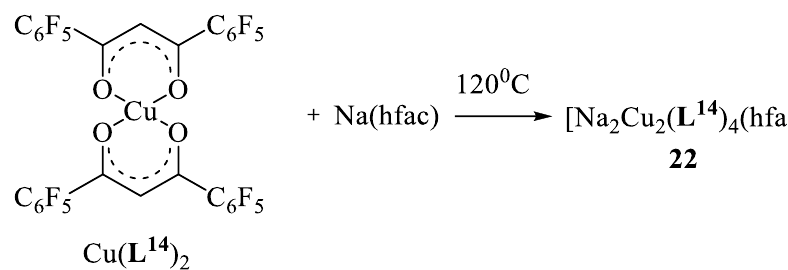
Scheme 10. Synthesis of heterometallic [Na-Cu] complex ( 22 ).